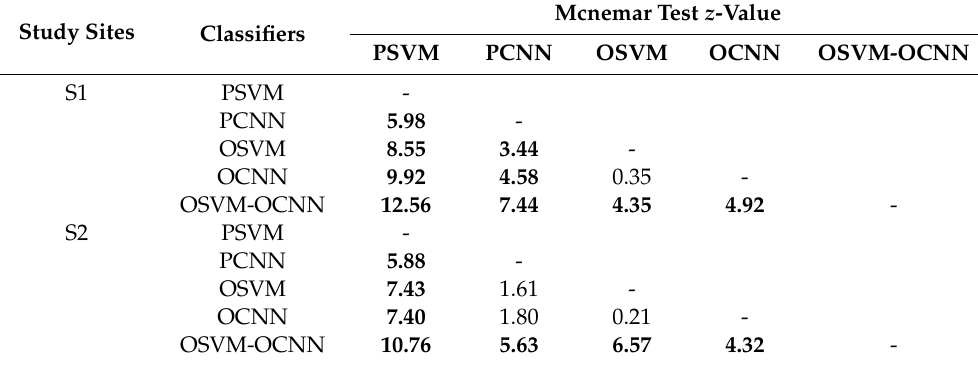
Table 5. McNemar test results for comparing the performance of the five methods over both study sites; bold font indicates that the compared two methods are significantly di ff erent at the 95% confidence level.